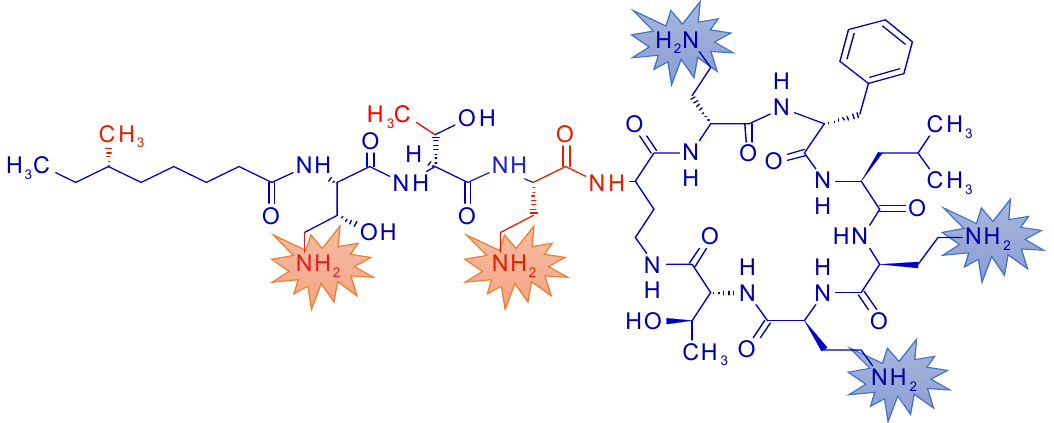
Figure 1. The structure of polymyxin B2 and NAB739. Polymyxin B2-specific functional groups are indicated with red font. Stars outline charged –NH 2 groups.